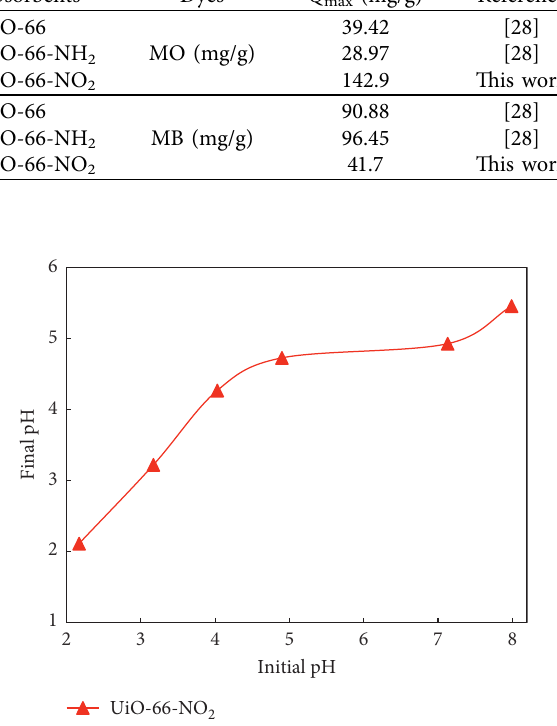
Figure 7: Determination of the point of zero charge (pH UiO-66-NO 2